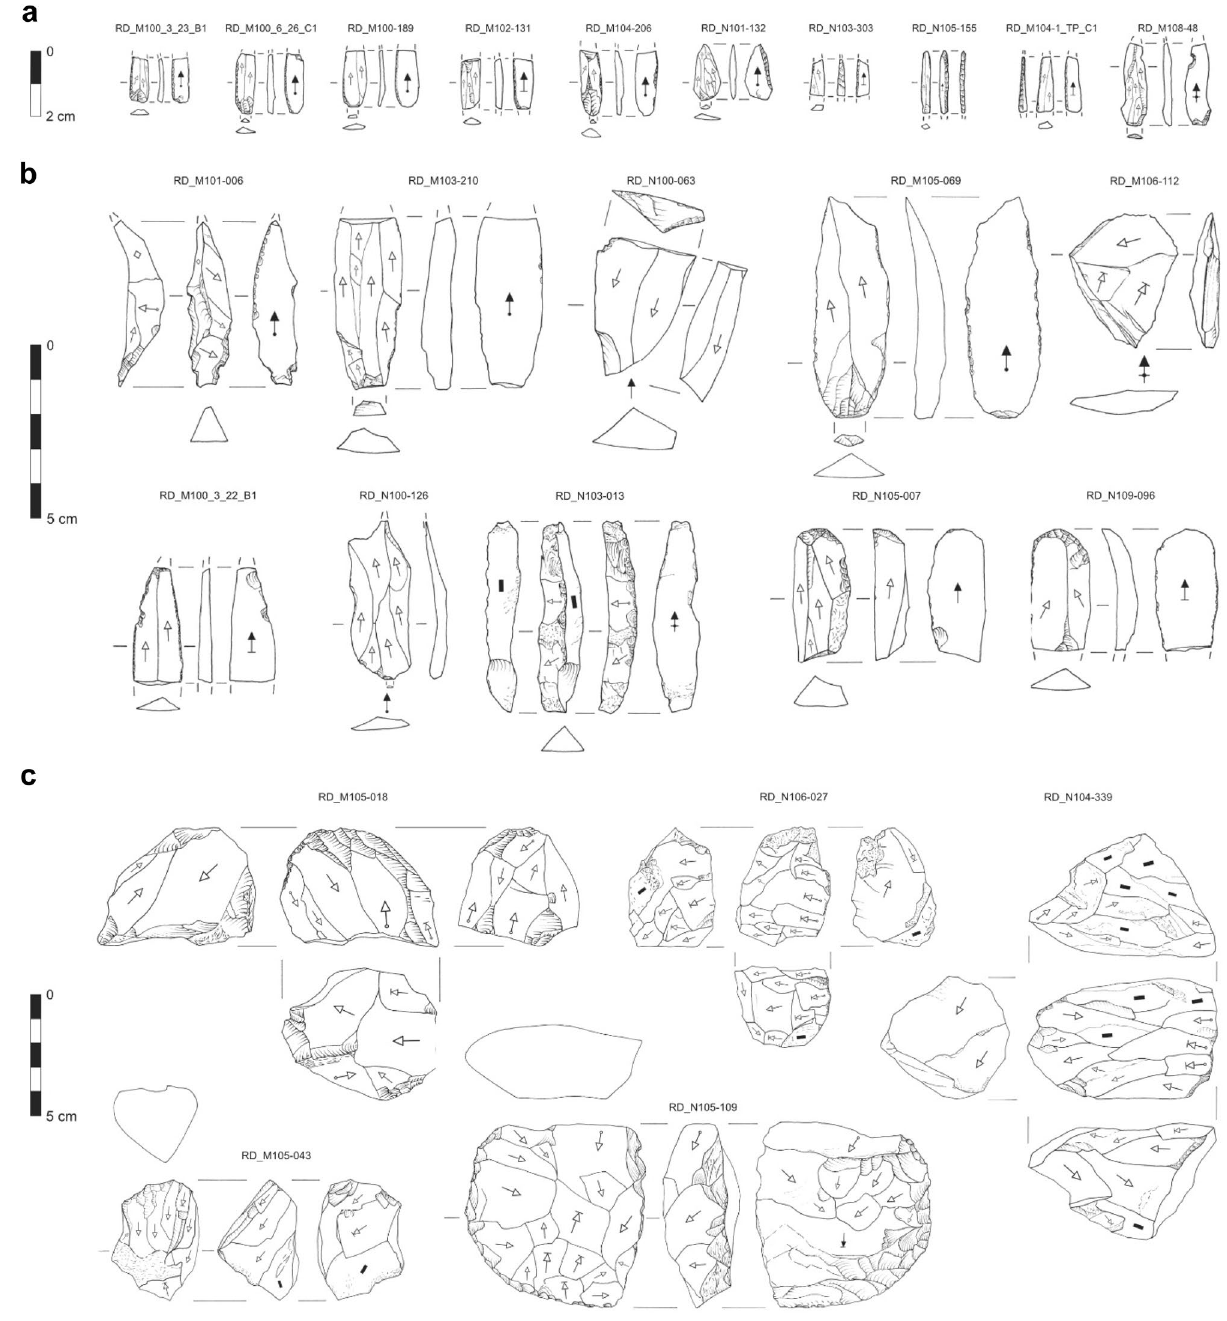
Figure 6. Selection of ( a ) bladelets, ( b ) blades and flakes and ( c ) (pre-) cores from Române ș ti- Dumbrăvi ț a I, GH3, 2016–19 Negatives, preserving at least undisturbed width, were present on 35% of the debitage and were unidirectional; most showed a final bladelet removal. Blade and bladelet profiles were primarily straight or twisted (Supplementary Table 3). Twisted profiles were found among asymmetrical blades and bladelets (Fig. 6a,b). Curved profiles were more frequent among blade blanks than among bladelet blanks. Complete and semi-complete debitage were mostly blanks or related to core shaping (Supplementary Table 4). Management debitage was more frequent among flakes and blades than bladelets (Supplementary Fig. 6). 72 artifacts were retouched (Table 2). Burins (dihedral or on truncations) were made on all debitage forms. Endscrapers were rare, manufactured on blades and a single flake. Retouched artifacts were primarily laterally retouched blades and bladelets, Dufour (subtype dufour) bladelets, and laterally backed blades and bladelets.